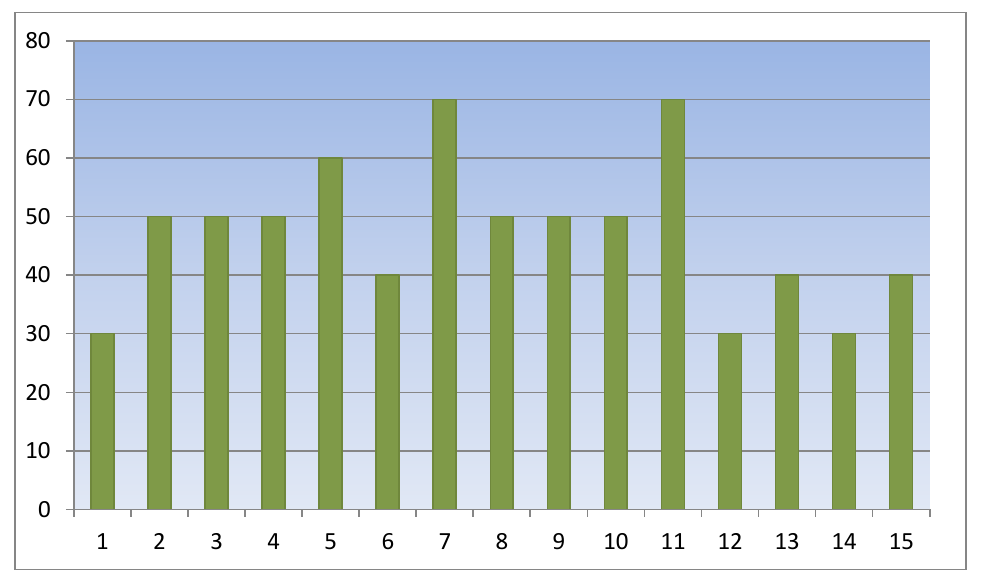
Table 2. Diagram Result of The Test in Cycle